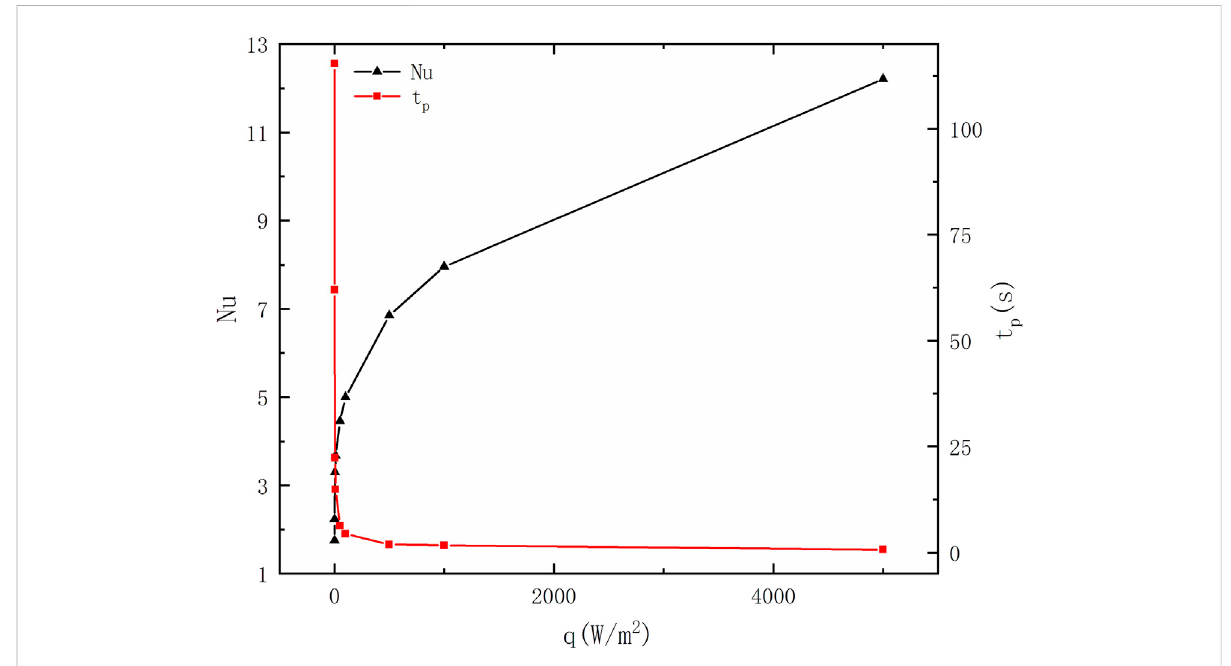
FIGURE 11 Variation of the Nusselt number Nu and fi rst peak time t p with the heat fl ux.